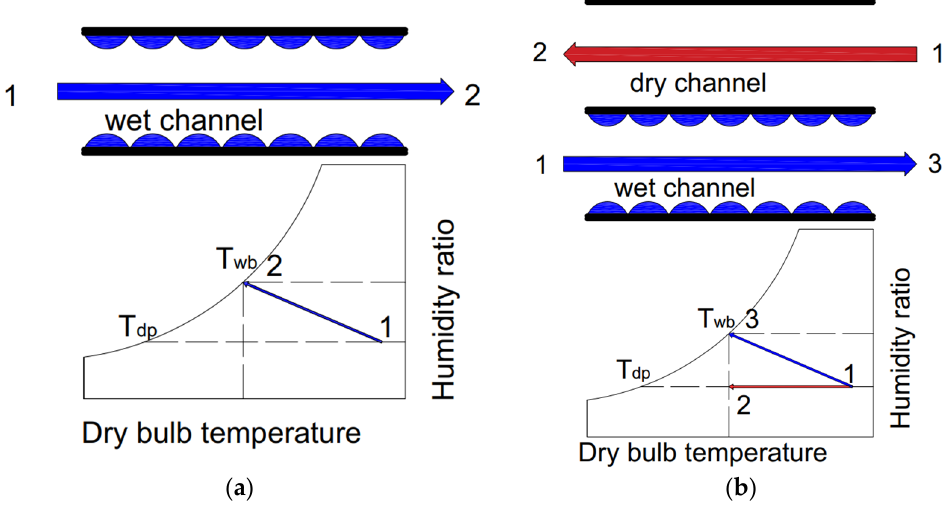
Figure 2. Principle of operation of standard evaporative cooling techniques [11]: ( a ) DEC, ( b ) IEC.